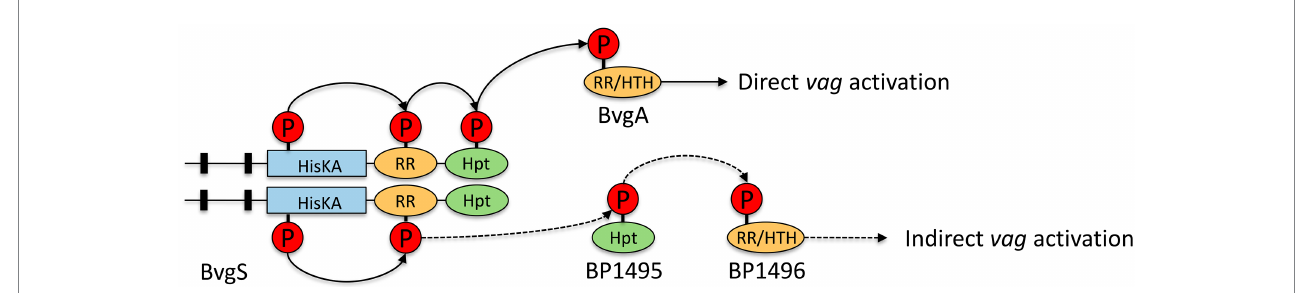
FIGURE 11 Scheme of putative indirect BvgA regulation on some vags such as dnt and bteA in Bordetella pertussis . Full arrows represent known phosphorylation pathways, dotted arrows represent hypothetical phosphorylation pathways. BvgS contains a Histidine-kinase (HisKA), a receiver (RR), and a Histidine phosphotransfer (Hpt) domains. BvgA is composed of a RR and an helix-turn-helix DNA-binding domain (HTH) (Dupré et al., 2015). A Hpt domain was predicted in BP1495 protein, a RR and a HTH domains were predicted in the BP1496